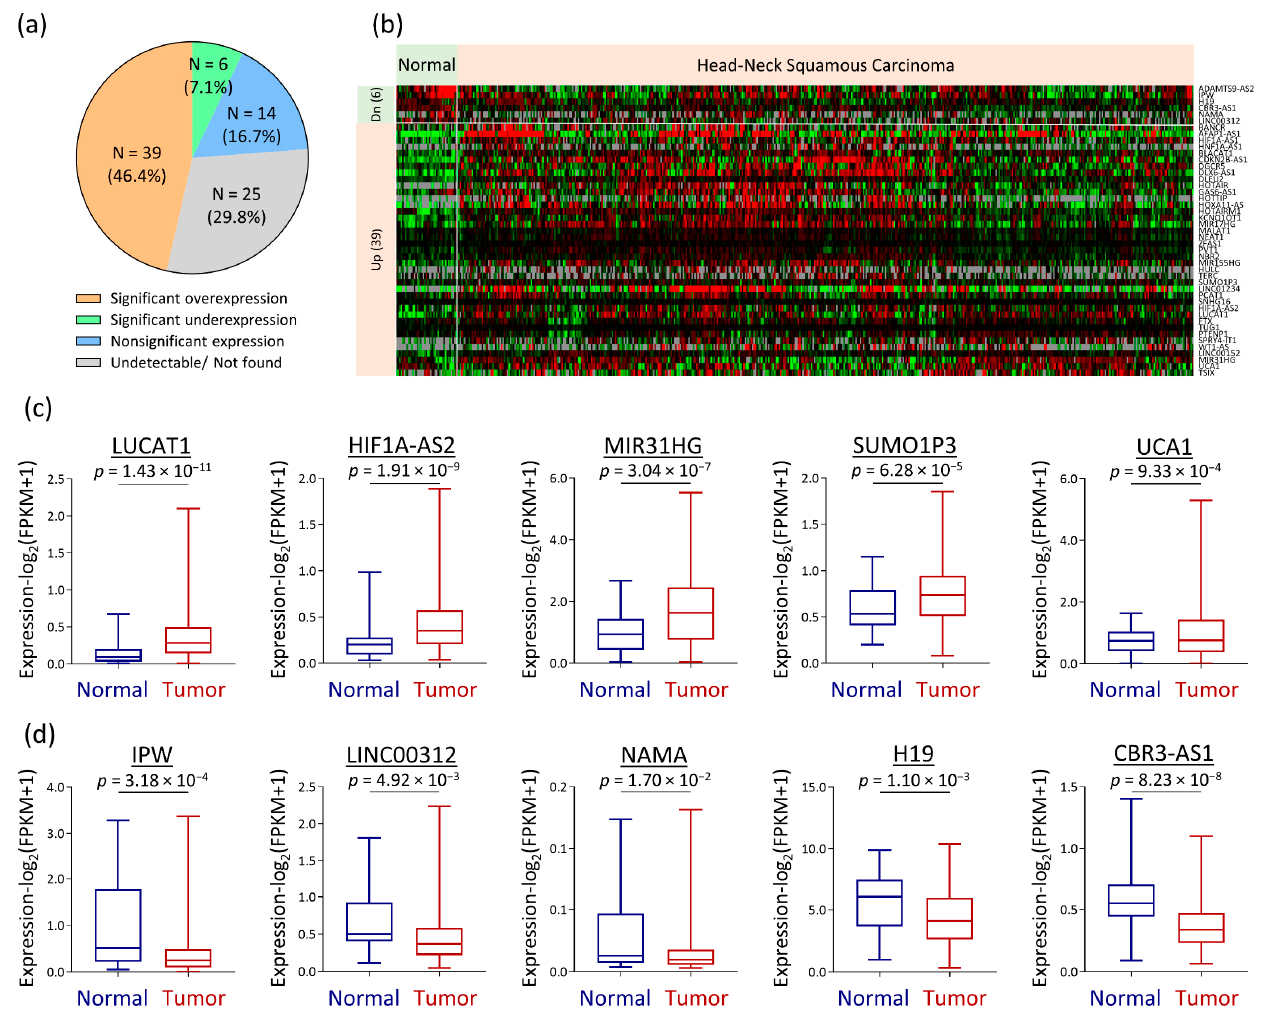
Figure 2. The differential expression profile of 84 lncRNAs in TCGA-HNSC dataset. ( a ) A pie chart of differentially expressed lncRNA in tumors (N = 497) compared to normal tissues (N = 44) as determined by unpaired t-test. A total of 45 lncRNAs are altered expression, including 39 overexpressed and 6 underexpressed lncRNAs in tumors. ( b ) Clustergram shows differential expression profiles of the 45 lncRNA across samples. ( c ) Examples of 5 overexpressed lncRNAs in tumors. ( d ) Examples of 5 underexpressed lncRNAs in tumors. Table 2. Significantly differentially expressed lncRNAs in TCGA-HNSC .